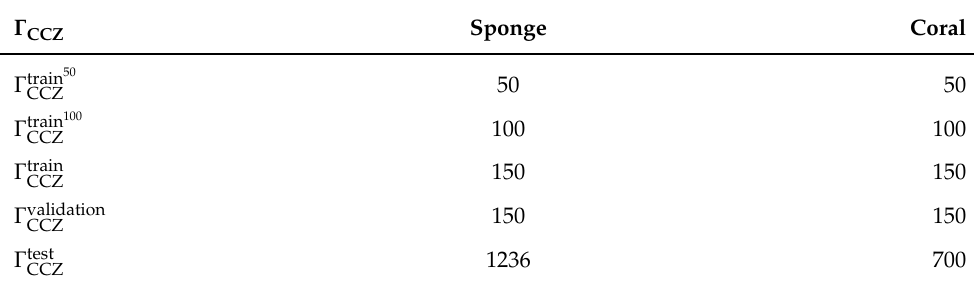
Table 2. Sample sizes of category per subset in the Γ CCZ